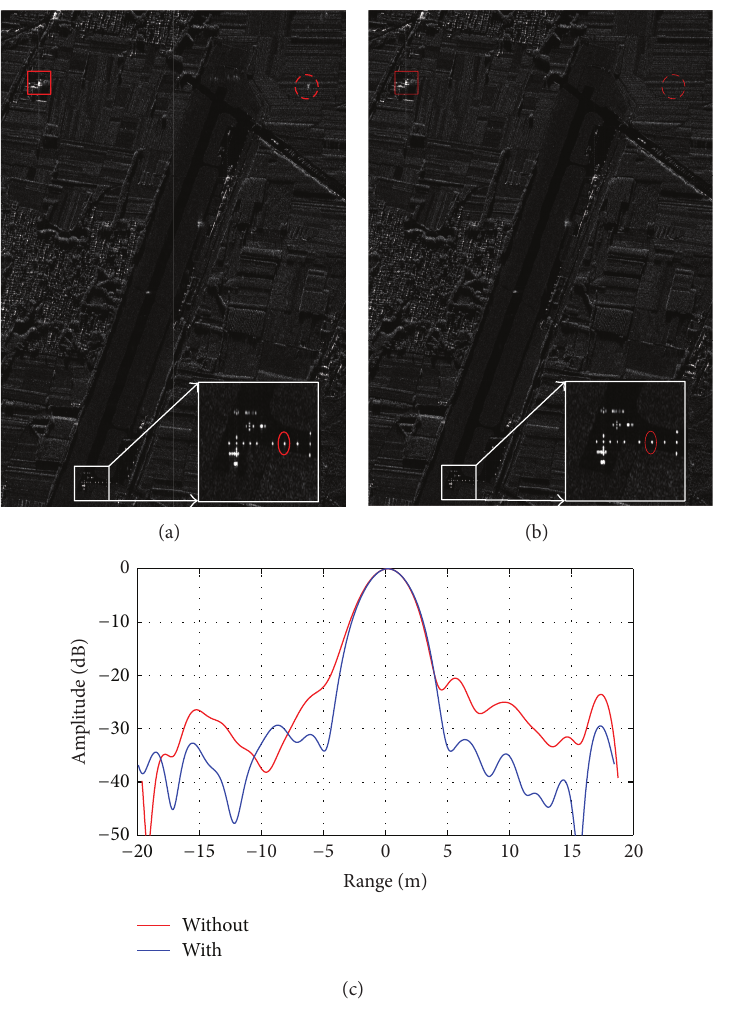
Figure 8: Real raw data results for OFDM-MIMO SAR. (a) Without correction. (b) With correction. (c) Range comparison of the amplification of the corner reflector.